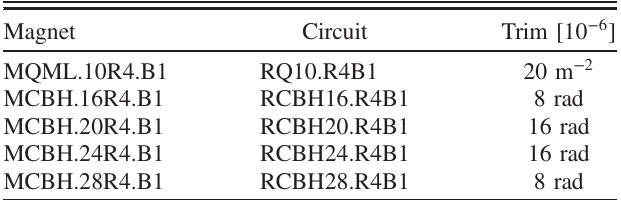
Fig. 16, highlighting in grey the problematic arc. 20% peak β -beating is considered the upper limit to safely operate the LHC and in 2016 with β (cid:1) ¼ 40 cm the rms β -beating in the machine was brought down to the 2% r.m.s. level [2].